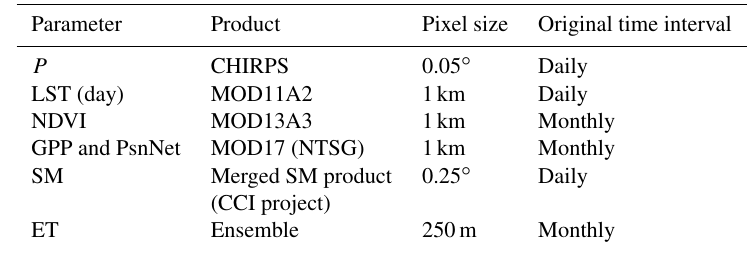
Table 1. Selected remote sensing